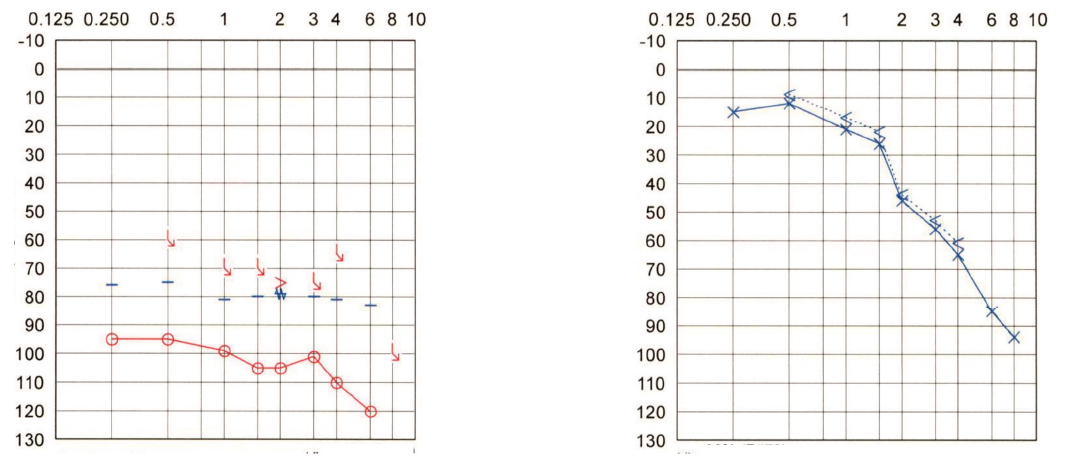
Figure 1. Pure tone audiogram of Patient #1 with right-sided profound hearing loss caused by scarlet fever 72 years